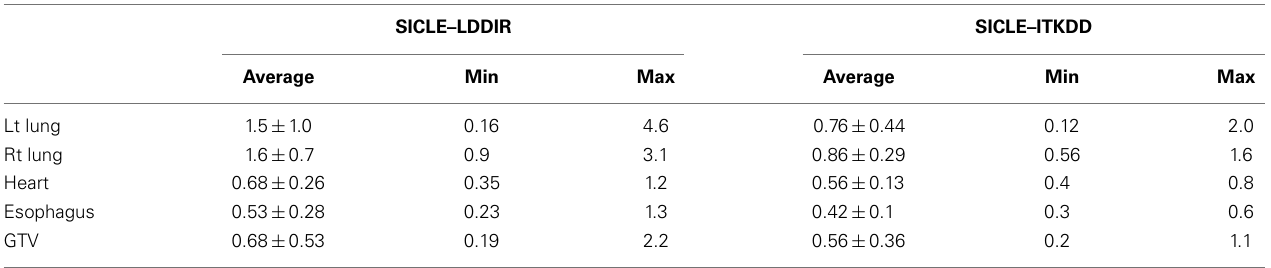
Table 4 | 2.5% volume boundary of SDVH for 13 patients .